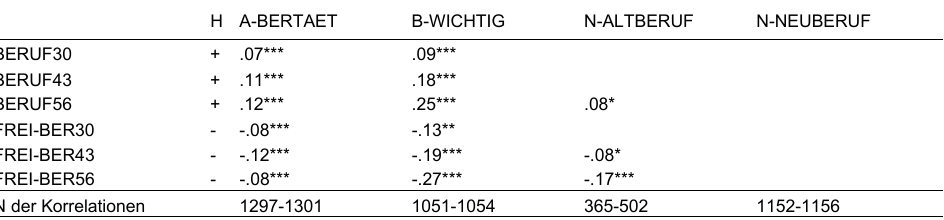
Tabelle 2 : Freizeitpräferenz und Kontinuität der Berufslaufbahn: Korrelationen (Tau